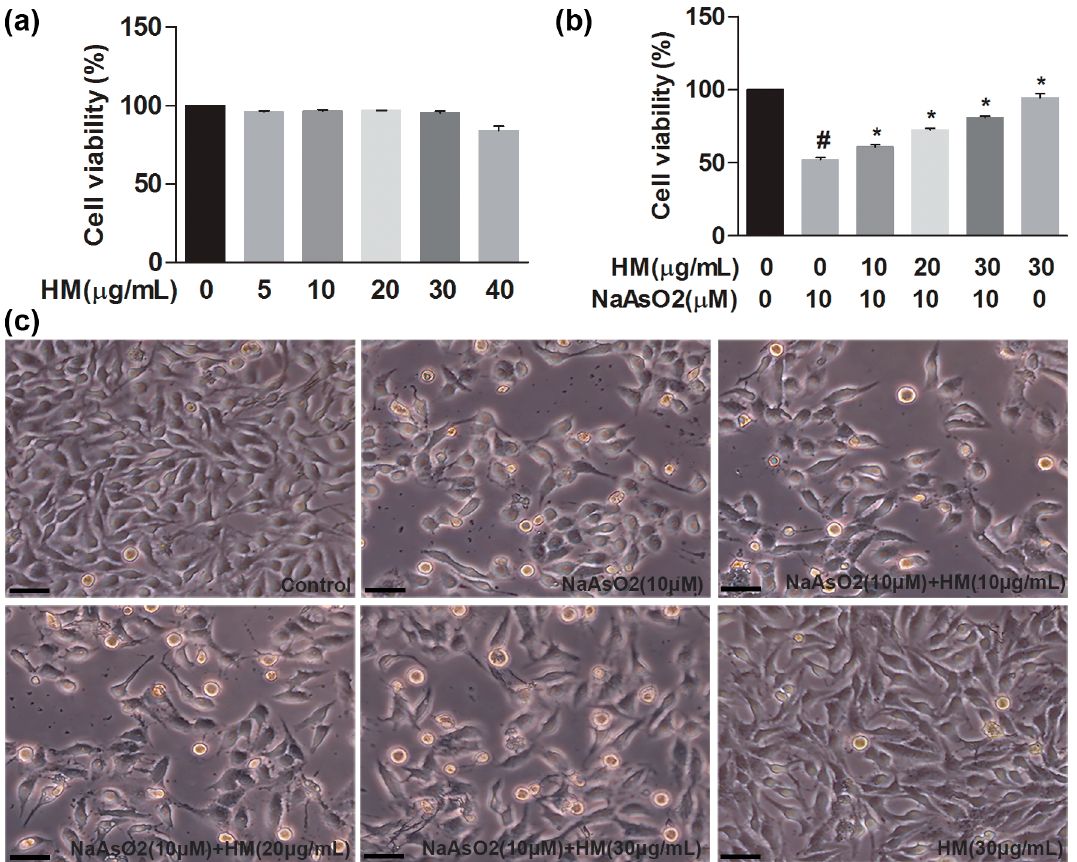
Figure 1. Hepatoprotective effects of HM against NaAsO 2 -induced oxidative stress in human liver cancer (HepG2) cells. ( a ) Cytotoxicity and ( b ) cell viability were measured by the 3-(4,5-dimethylthiazol-2-Yl)-2,5-diphenyltetrazolium bromide (MTT) assay; ( c ) observation of HepG2 cell morphology. Cells were pretreated with different concentrations of HM for 1 h, followed by co-treatment with NaAsO 2 for 24 h. Scale bar: 200 μ M. Data are expressed as mean ± standard error mean (SEM) of three independent experiments. # p < 0.05 compared with the control and NaAsO 2 group, and * p < 0.05 compared with the NaAsO 2 and HM extract-treated groups.